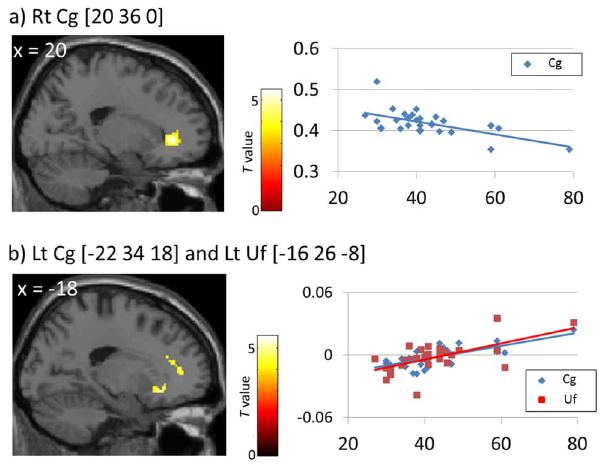
Figure 1. Relationship between state anxiety and FA. State anxiety scores were negatively associated with Pre FA in the right anterior Cg (a, r = 2 0.61, p =0.0004) and Post–Pre FA in the left anterior Cg ( b , r =0.70, p =0.00002) and the left Uf ( b , r =0.65, p =0.0001), as illustrated by the scatter plots on the right. Vertical axes represent FA values at peak voxels in each cluster and horizontal axes indicate total state anxiety scores. The left Uf and the Ac were included in the same cluster. FA, fractional anisotropy; Rt, right; Lt, left; Cg, cingulum; Uf, uncinate fasciculus.